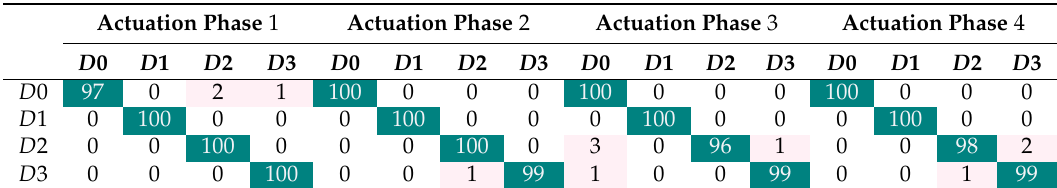
Table 1. Confusion matrix of the application of the t -SNE based damage detection and classification procedure presented in Sections 3 and 4 to the case of the aluminum plate in Scenario 1 , in the frequency domain . Rows represent true values, while columns represent predicted values.